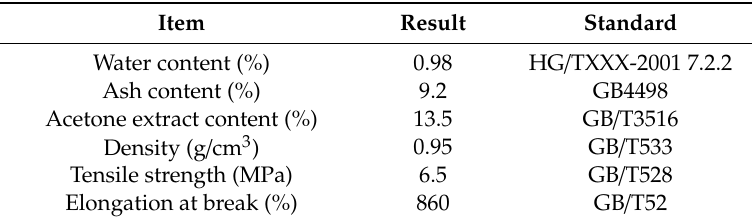
Table 2. Properties of crumb rubber.